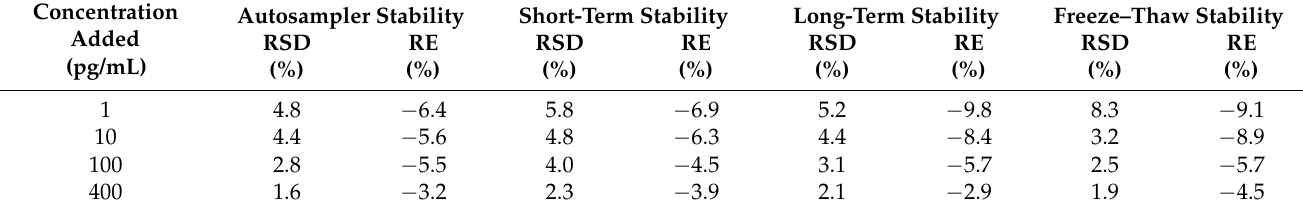
Table 2. Stability results of OXA in rat vitreous body in different conditions (n =